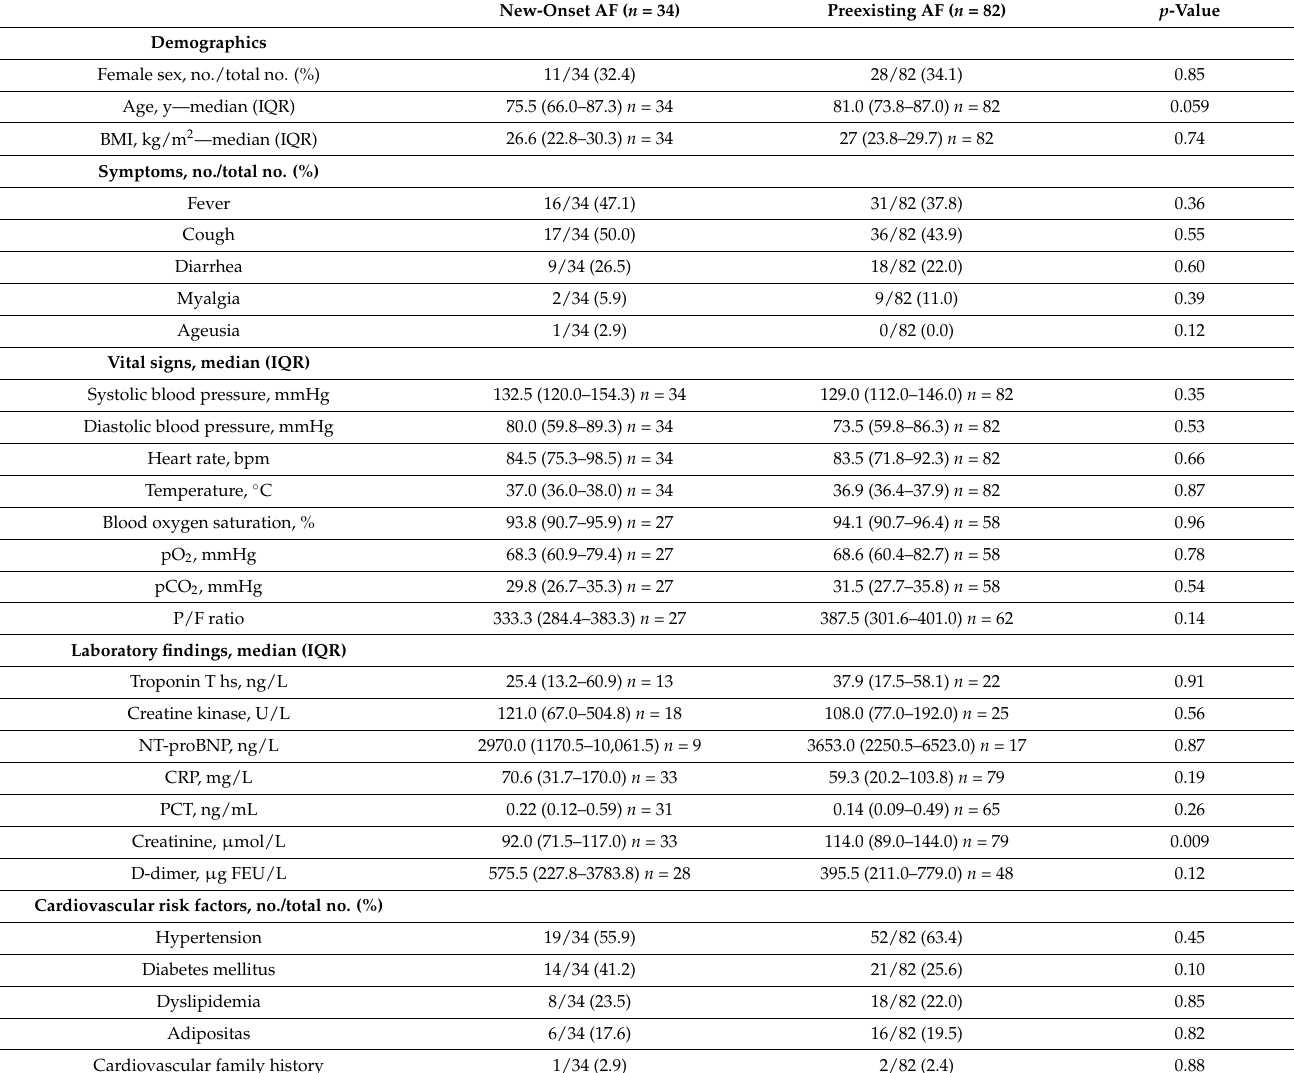
Table 2. Characteristics of COVID-19 Patients with New-onset and Preexisting